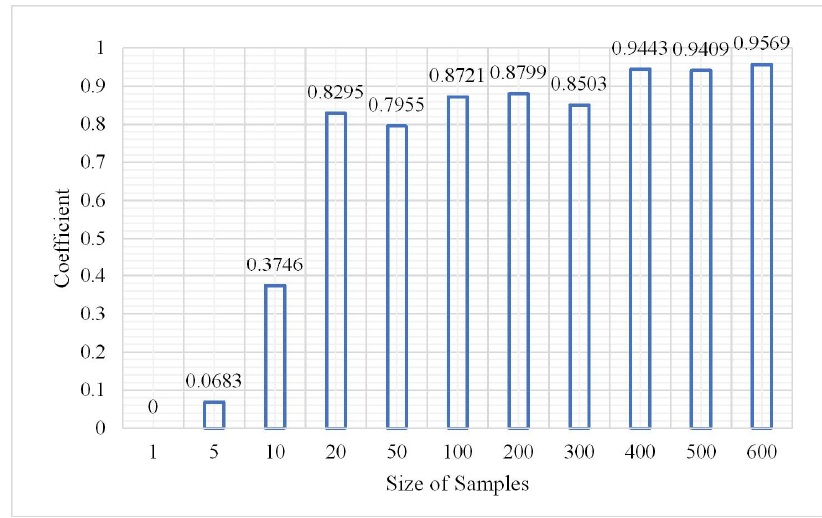
Figure 20. Change in overall accuracy.